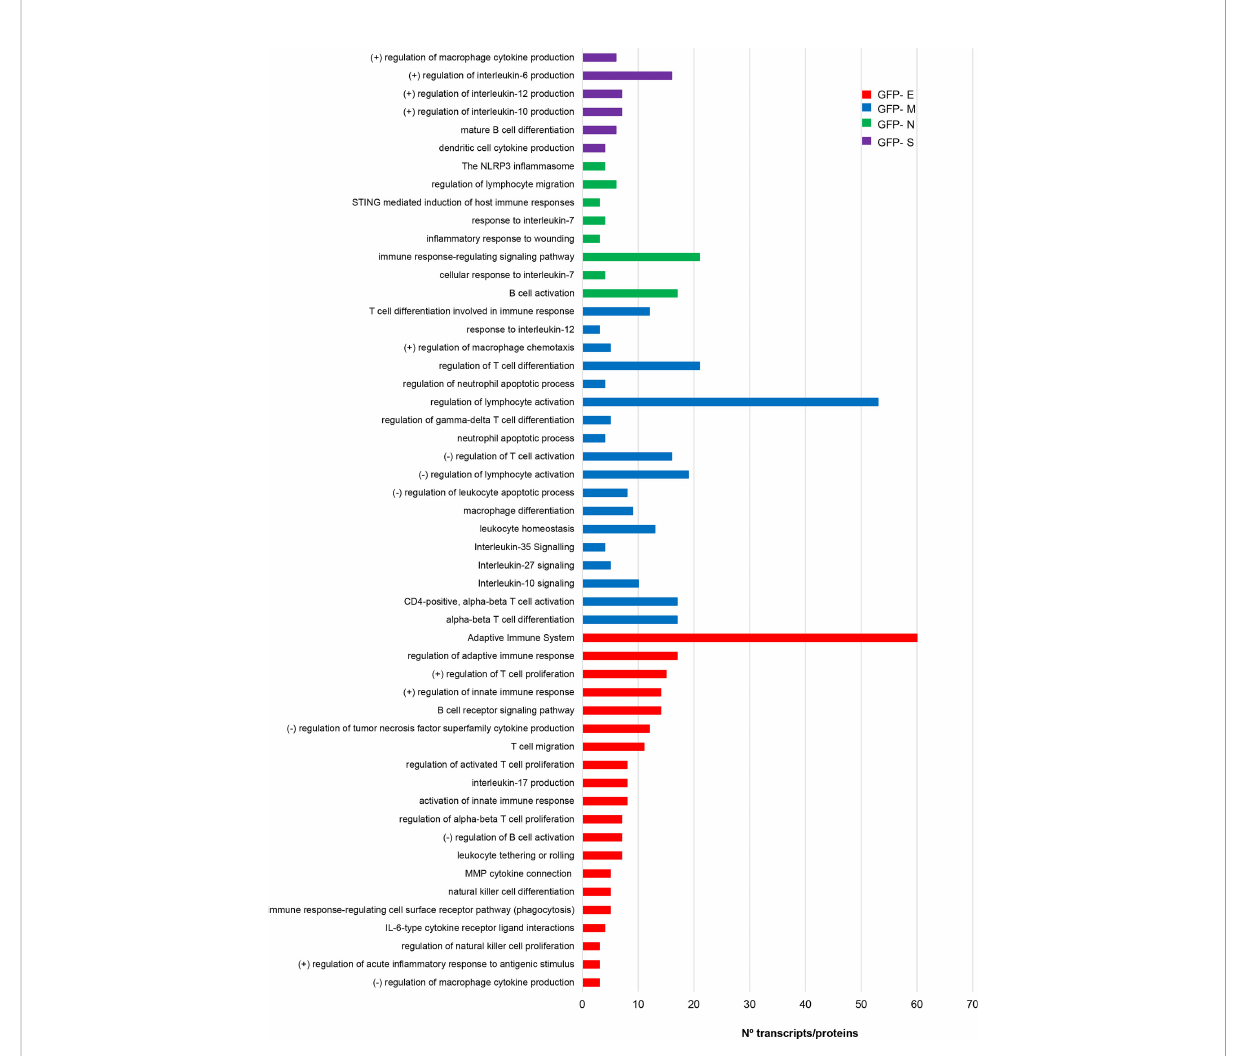
FIGURE 7 The expression of SARS-CoV-2 structural proteins differentially modulate the immunological capacity of OBC1 cells. Processes related to immune system were directly extracted from the functional analysis of proteotranscriptomic datasets (see Supplementary Table 6 for more